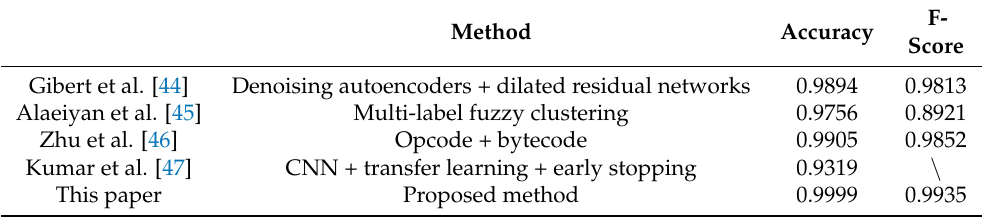
Table 6. Comparison with other relevant literature when using the Microsoft